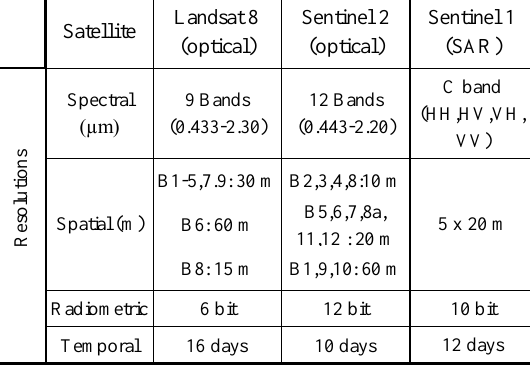
Table 1. The characteristics of the satellite data used (Url-1,